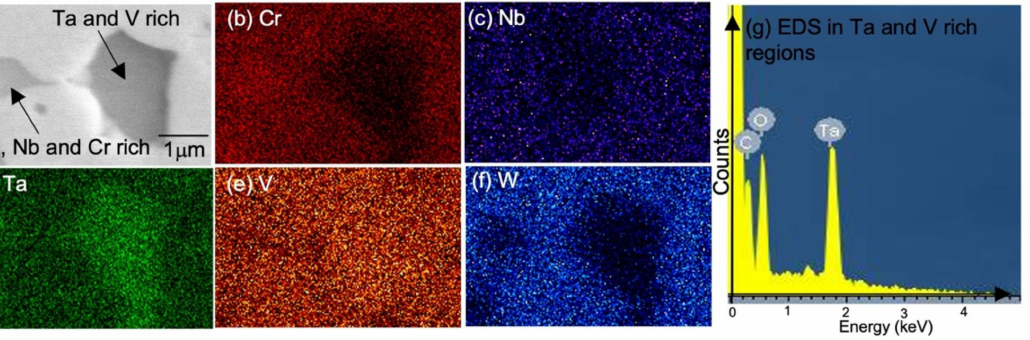
Figure 3. ( a ) SE image of the CrNbTaVW microstructure and the corresponding EDS maps for the ( b ) Cr-Lalpha, ( c ) Nb-Lalpha, ( d ) Ta-Lalpha, ( e ) V-Lalpha, ( f ) W-Lalpha and ( g ) EDS spectrum for regions rich in Ta and